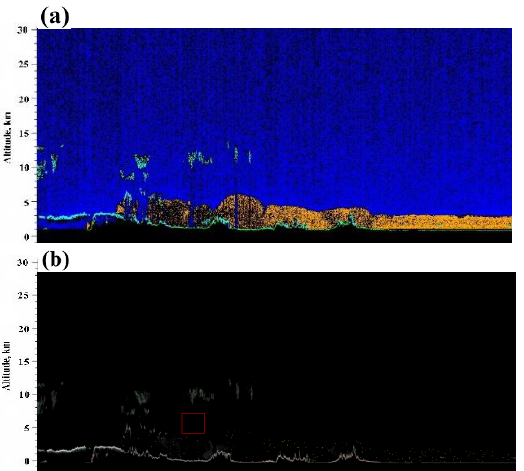
Figure 4. ROI algorithm selection (a), result of random selection(b)